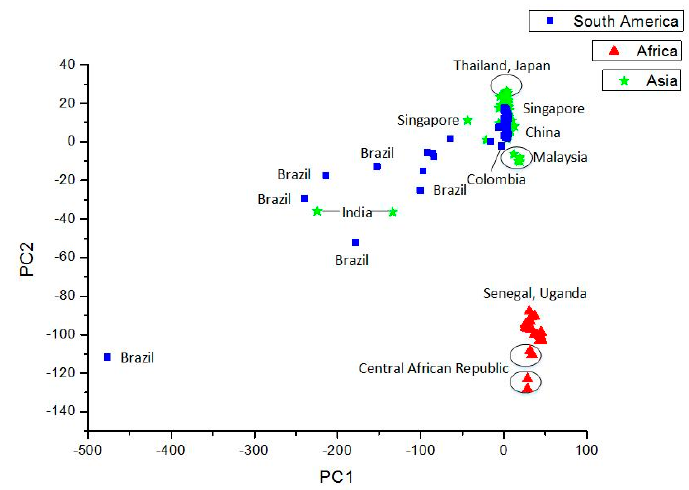
Figure 4. Principal component analysis (PCA) score plots of ZIKV strains from different continents.